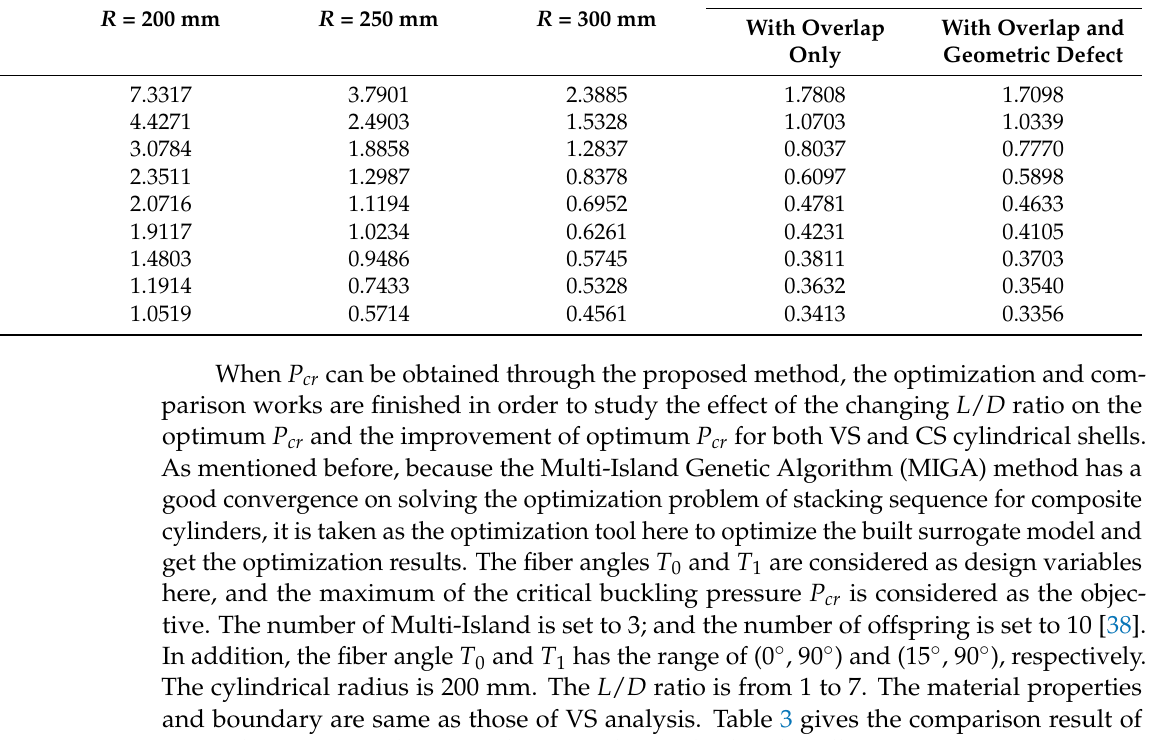
P cr (MPa) Defect Consideration, R = 350 mm With Overlap With Overlap Only